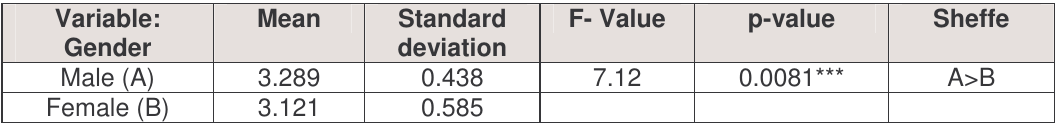
Table 2: ANOVA between gender groups regarding Personal Management